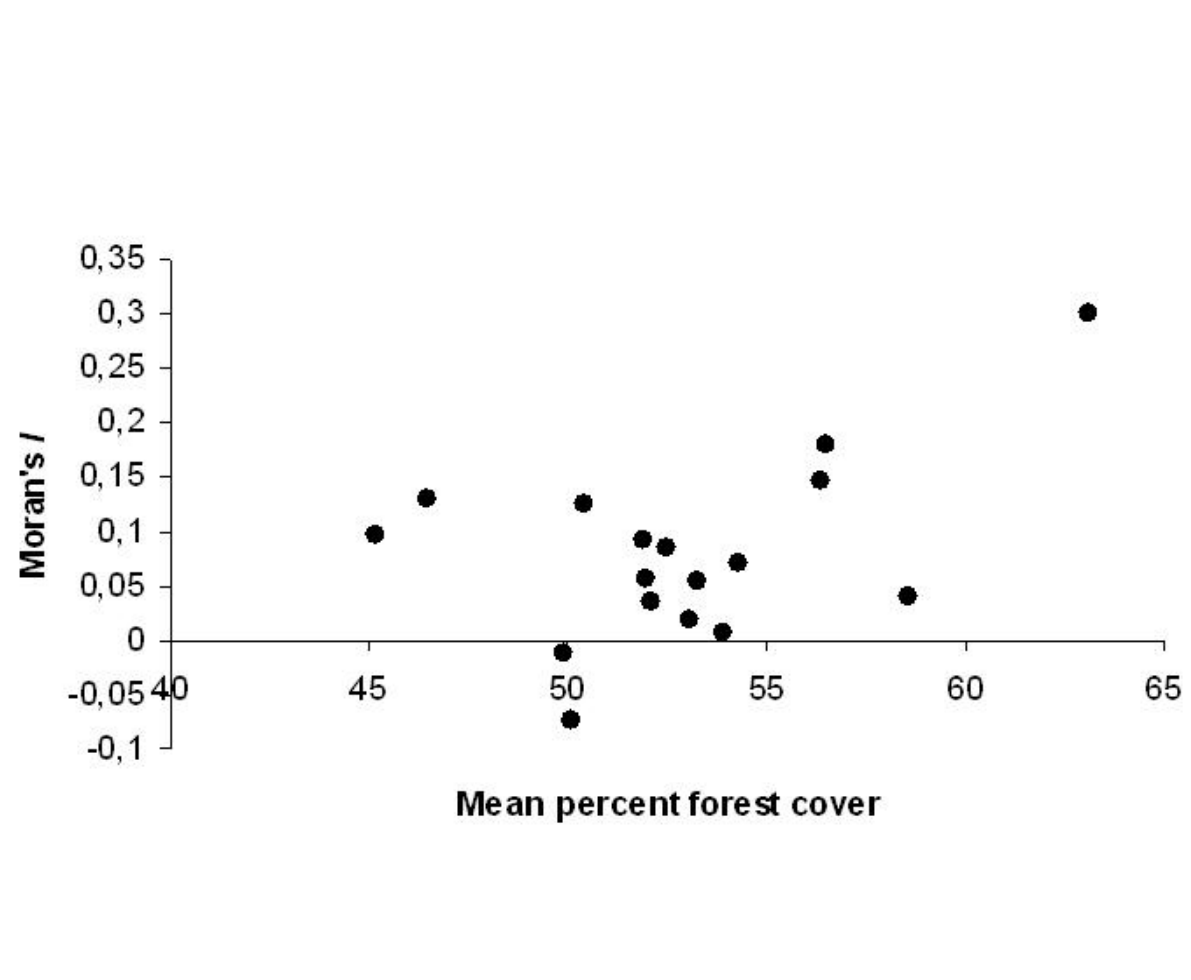
Fig. 2. Sensitivity to forest cover and spatial autocorrelation of residuals, calculated with Moran’s I coefficient, for 17 forest bird species, within 50 km of Quebec City (46°45’ N, 71°20’ W), Québec, Canada. Each dot represents a